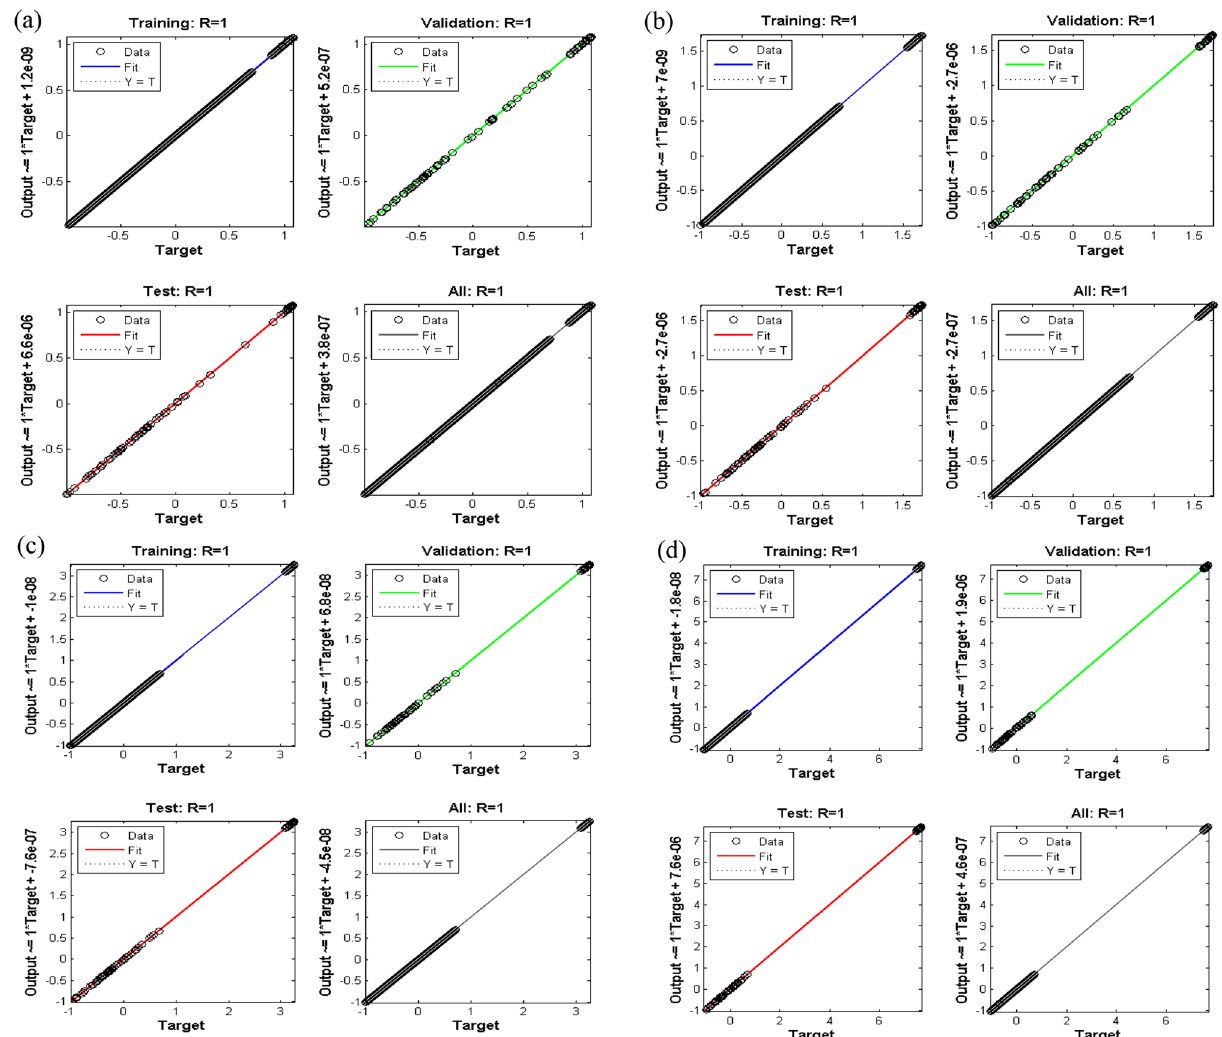
Figure 12. Regression plots of case study 1: scenario 1 ( a ) case 1, ( b ) case 2, ( c ) case 3 and ( d ) case